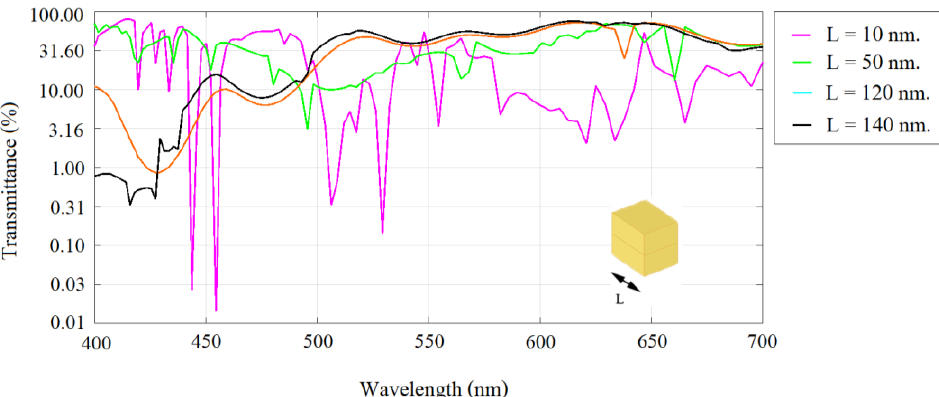
Figure 3. Transmittance when L is varied from 10 to 140 nm.